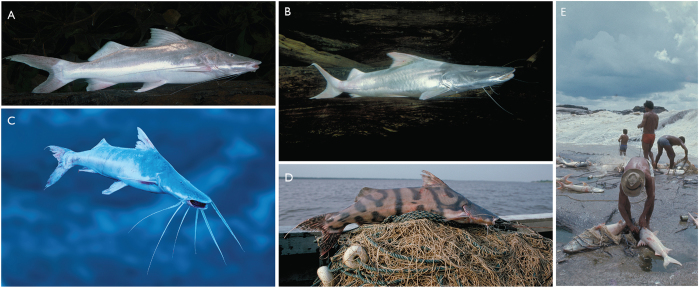
Migratory goliath catfishes (Brachyplatystoma, Pimelodidae).(A) B. vaillantii (piramutaba in Portuguese, pirabutón in Spanish); (B) B. rousseauxii (dourada in Portuguese, dorado in Spanish); (C) B. platynemum (babão in Portuguese, mota flemosa in Spanish); (D) B. juruense (zebra in Portuguese, zebra in Spanish); (E) Dorado migrations exploited by fishermen. The Santo Antônio Dam on the Madeira River now drowns the Teotônio Rapids (shown here) where B. rousseauxii (species in photo) and B. platynemum were previously exploited and easily detected when migrating. Photos by M. Goulding.